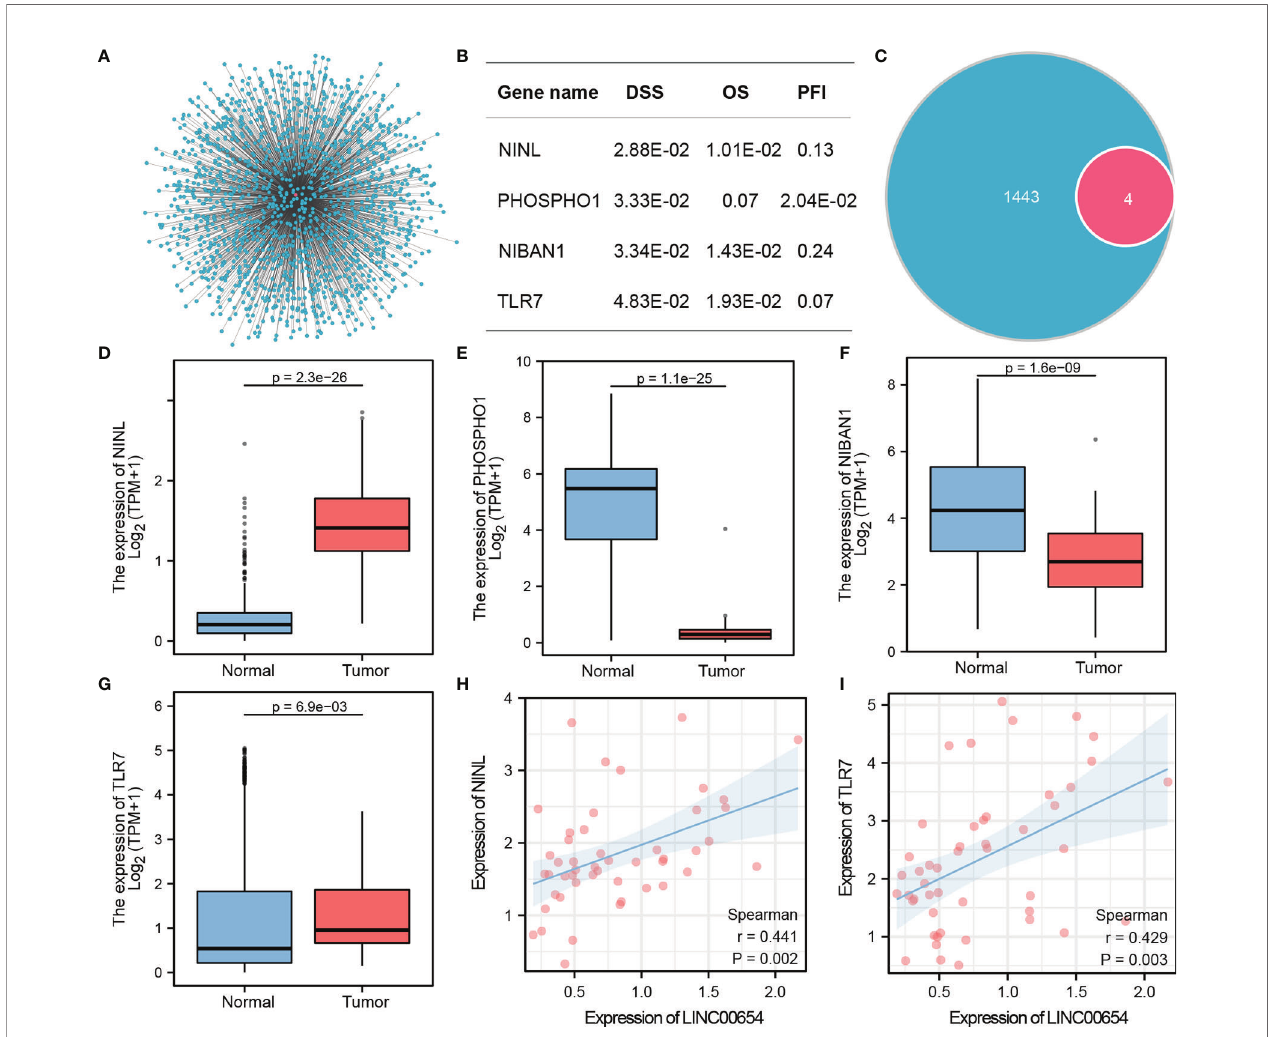
FIGURE 3 | Identi fi cation of the Hub downstream target gene, NINL, of LINC00654. Co-expression genes of lnc00654, and batch cox regression analysis of all genes, four signi fi cant genes are list (A, B) . Venn fi gure shows the signi fi cant genes and target genes, expression validates genes between normal and tumor groups (C – G) . Correlation coef fi cients are used to screen the best candidates (H, I)